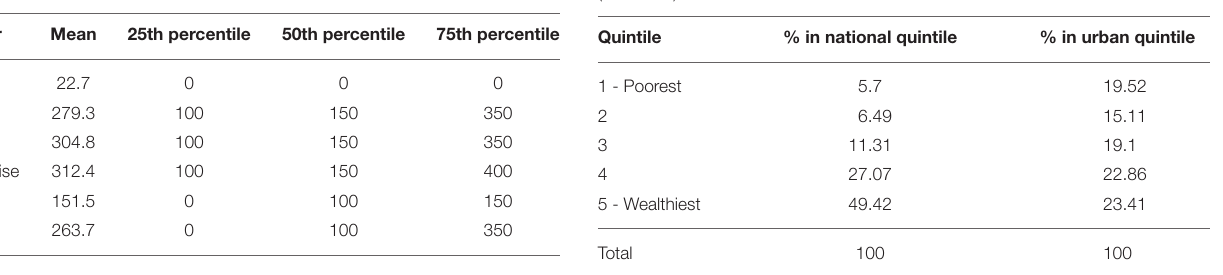
TABLE 3 | Amount Paid for Services (in Kenyan Shillings), by Sector Visited or reason for visit.